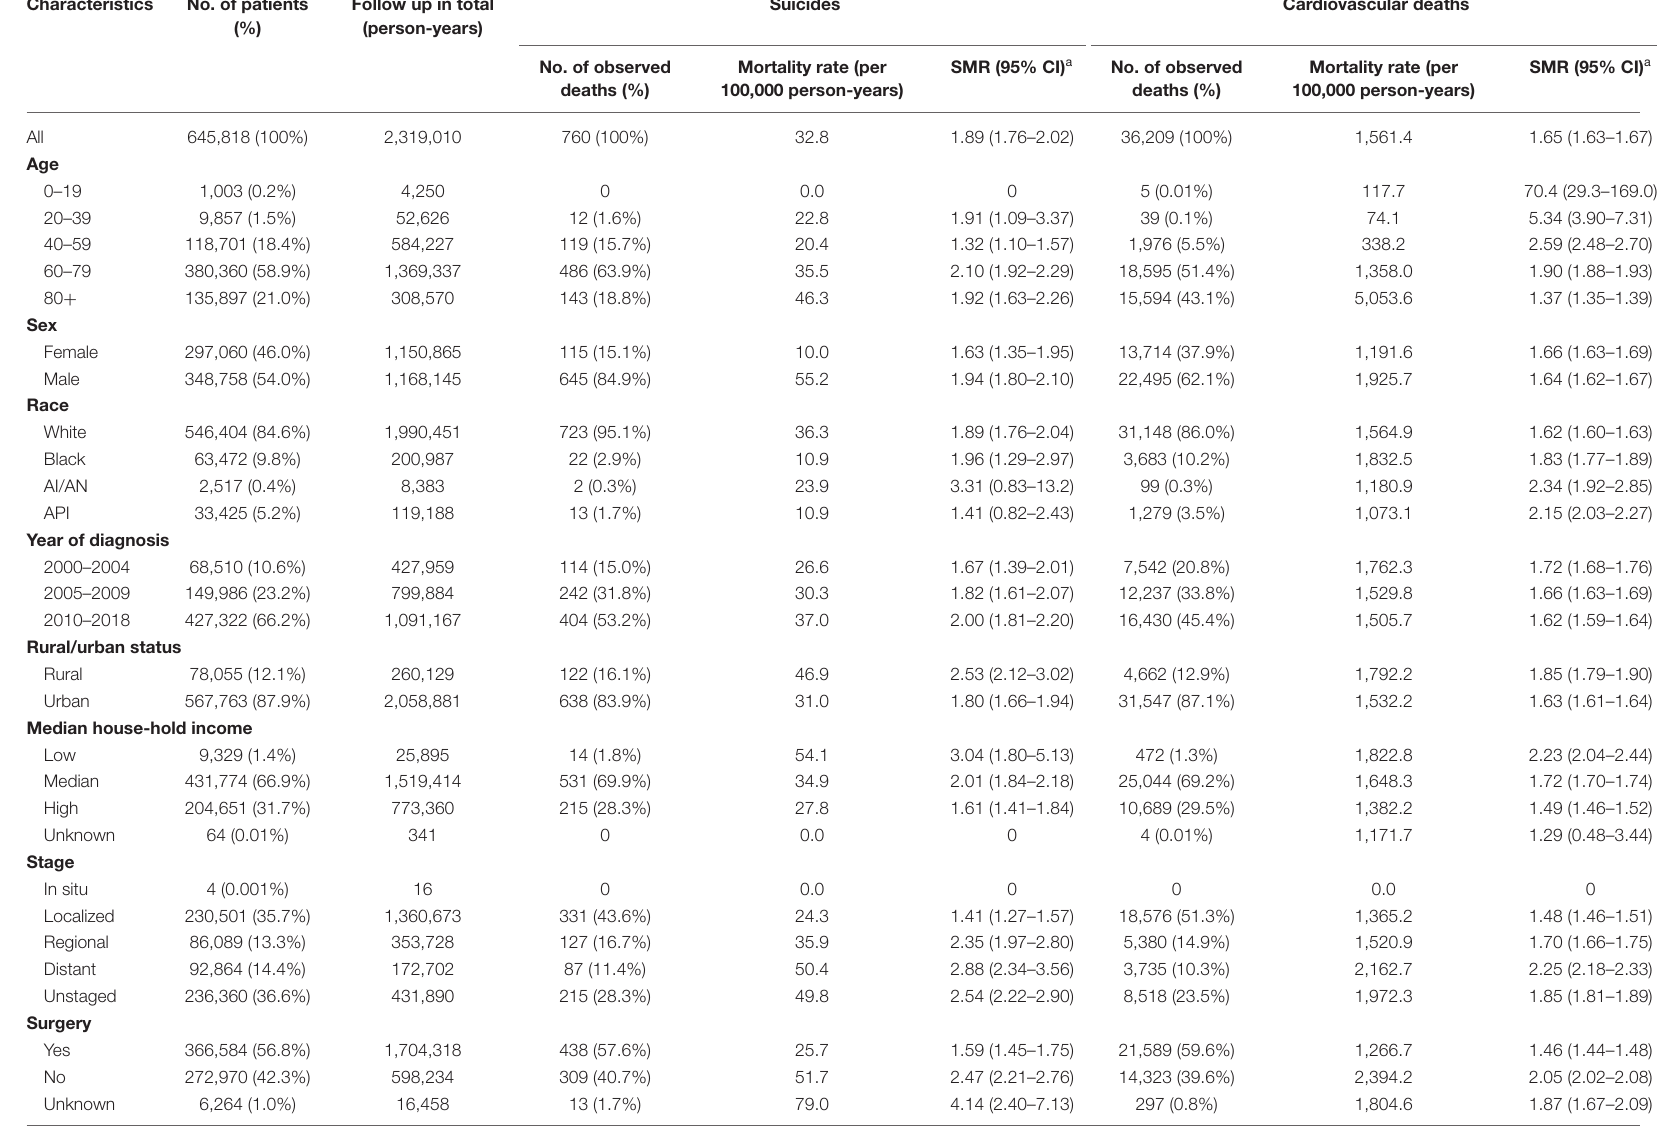
TABLE 1 | Suicide and cardiovascular death among patients with multiple primary cancers by baseline characteristics.